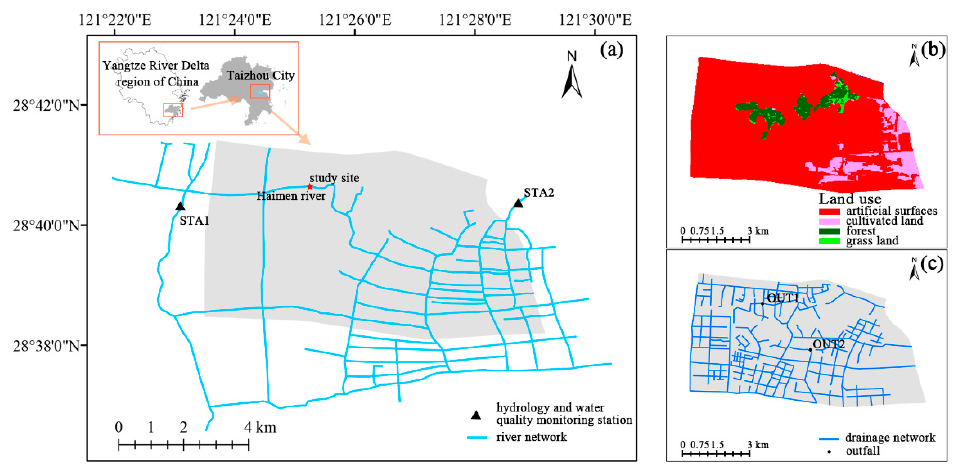
Figure 1. Map of the target area ( a ), land-use type ( b ), and distribution of the pipeline network ( c ).